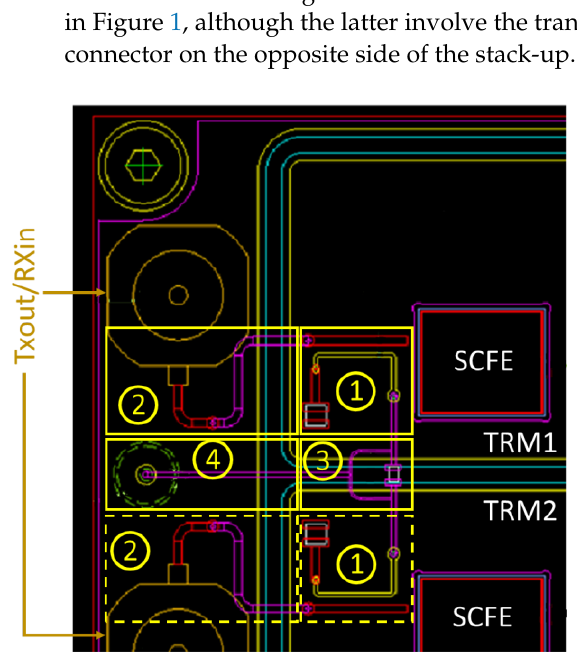
Figure 3. Overview of the RF transitions of interest that have been accurately